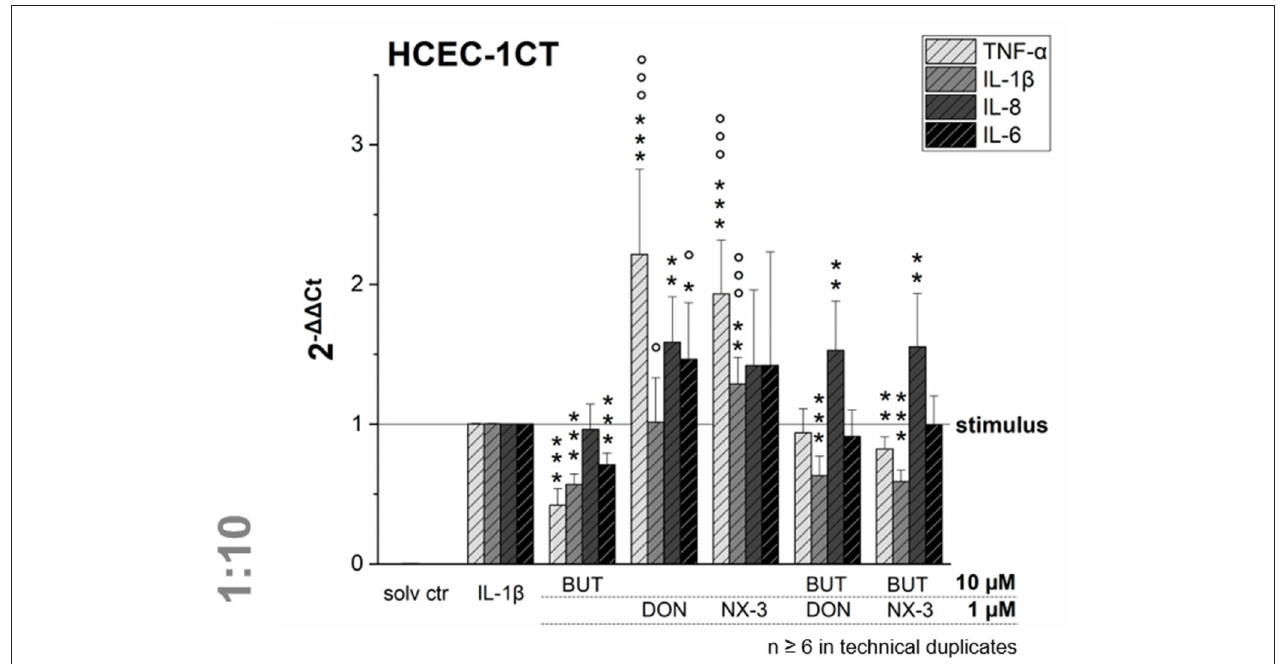
FIGURE 4 | Gene transcription levels of TNF- α , IL-1 β , IL-8, and IL-6 in HCEC-1CT cells after 2h pre-incubation with BUT (10 µ M), DON (1 µ M), NX-3 (1 µ M) and respective 10:1 combinations, followed by 3h co-stimulation with IL-1 β (25ng/mL) measured by qRT-PCR. Transcription data are normalized to the gene expression levels of two endogenous control genes (ACTB1 and GAPDH) and referred to the stimulated solvent control levels. Data are expressed as mean values ± SD of at least six independent experiments performed in technical duplicates. Significant differences to the stimulated solvent control are indicated with * p < 0.05, ** p < 0.01 and *** p < 0.001, whereas significant differences of the combinatory data to the respective DON and NX-3 data are indicated with ◦ p < 0.05 and ◦◦◦ p < 0.001.